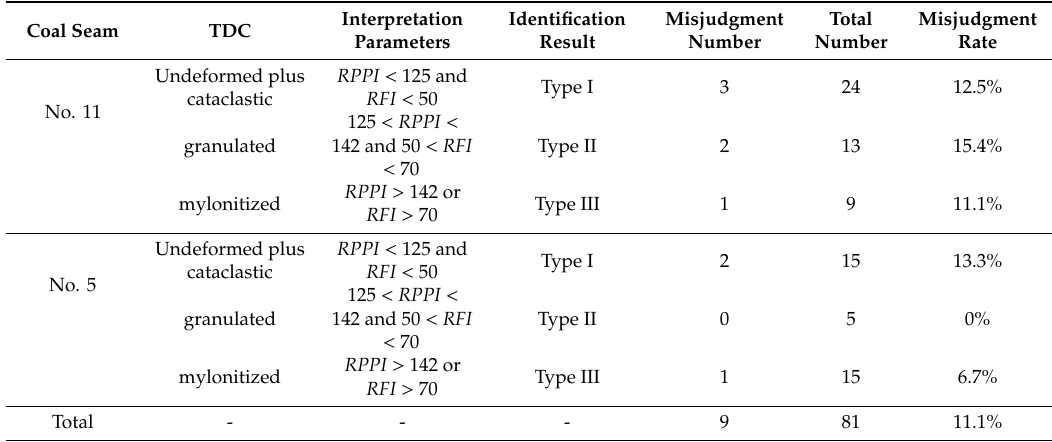
Table 5. Quantitative interpretation parameters and misjudgment rate of